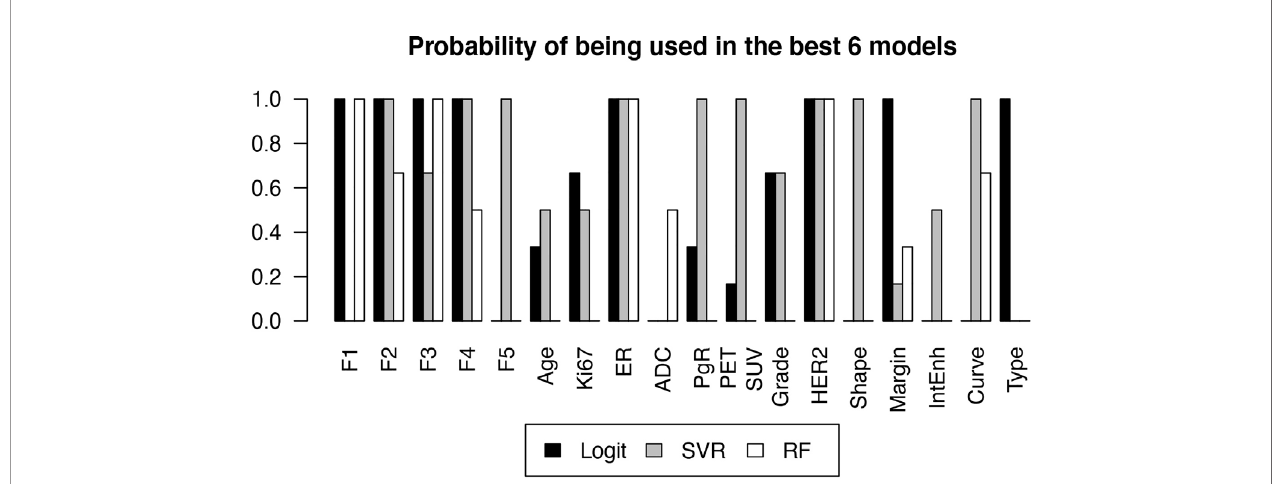
FIGURE 4 | Probability of each variable of being included in a high-performance model, estimated by the frequency with which the variable was selected in one of the 6 best models, as a function of the classi fi